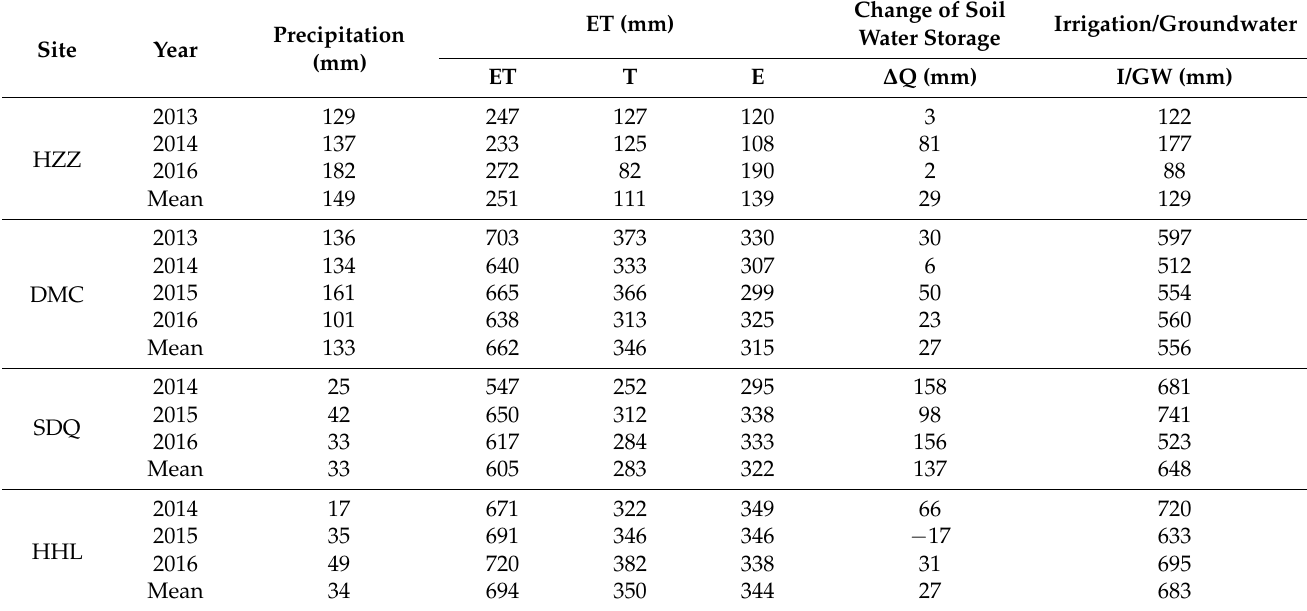
Table 3. Components of water budget in ecosystems of midstream and downstream.